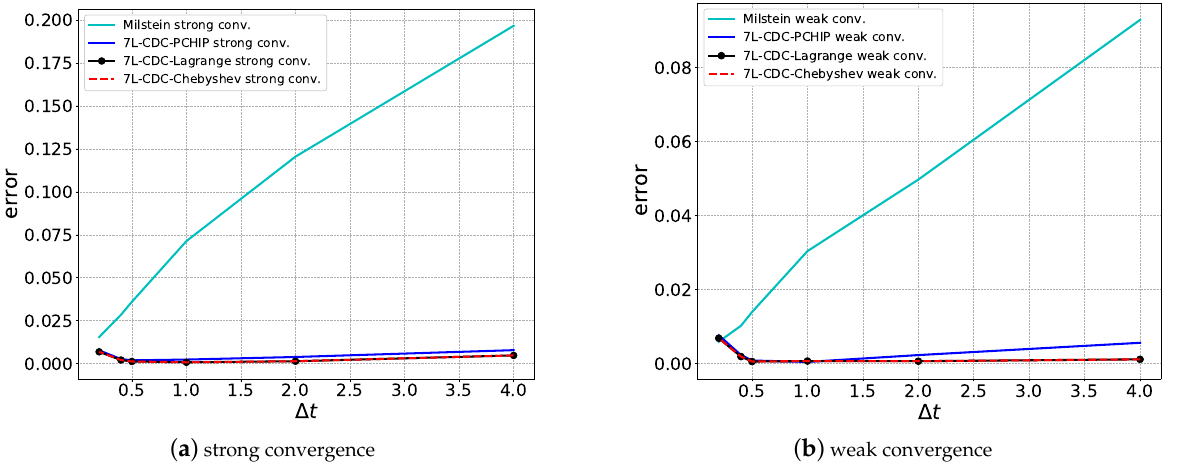
∑ | ˇ Y ( T ) − ˆ Y ( T ) | , see Equation (4) and the weak error k k M